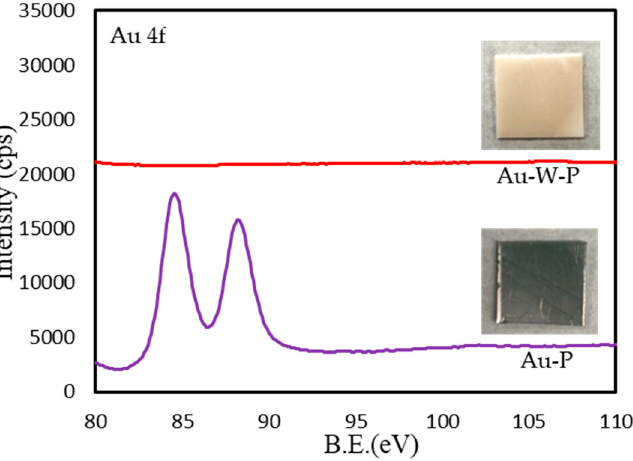
Figure 2. Photographs and XPS (Au 4f) results of Au sputtering samples before and after washing with aqua regia solutions.